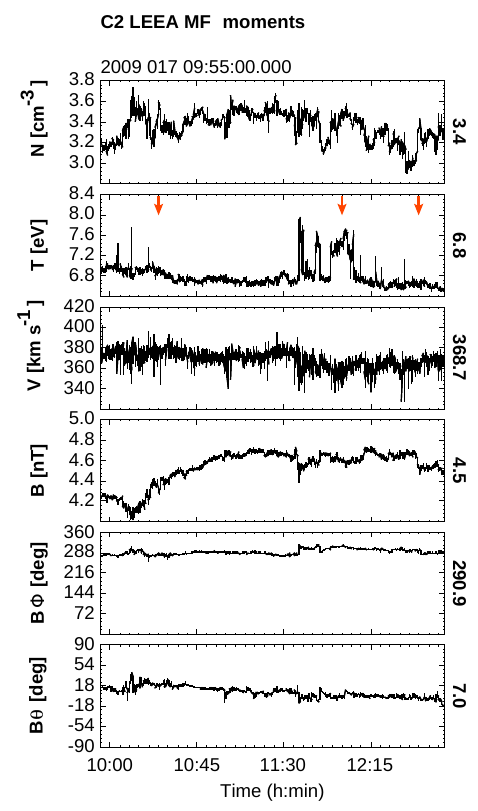
Figure 3. Plots of the total electron density, temperature, and speed and magnetic field components in spherical coordinates across the time interval in Fig. 2. The enhancements in the total temperature between 11:30 and 12:15 indicate times when the spacecraft was in the